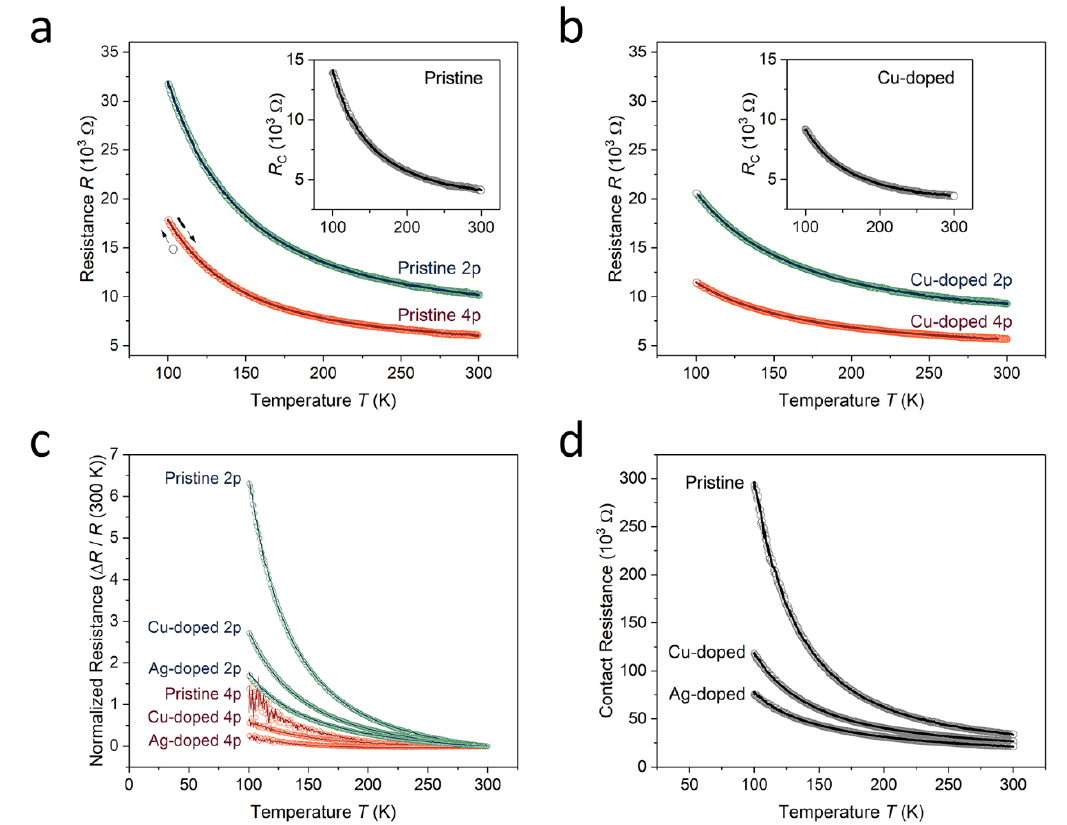
Figure 4. Contact resistances. ( a ) Temperature dependent resistances of a pristine monolayer RuO 2 nanosheet measured by the four- (orange) and two-probe (green) measurement techniques. The inset image shows the contact resistances of the nanosheet as a function of the temperature obtained from the two different measurement configurations. The open circles and solid lines indicate the data measured during temperature ramp-down and ramp-up, respectively. ( b ) Temperature dependence of the four-probes (orange), two-probes (green), and contact resistances (inset) obtained from the nanosheet after the surface decoration of Cu-nanoparticles. ( c ) Direct comparison of the temperature dependencies of the four- (orange) and two-point probe (green) measurements in pristine, Cu-doped, and Ag-doped states using the normalized resistances at room temperature. ( d ) Change of temperature-dependent contact resistance during the doping processes calculated from the two measurement configurations.